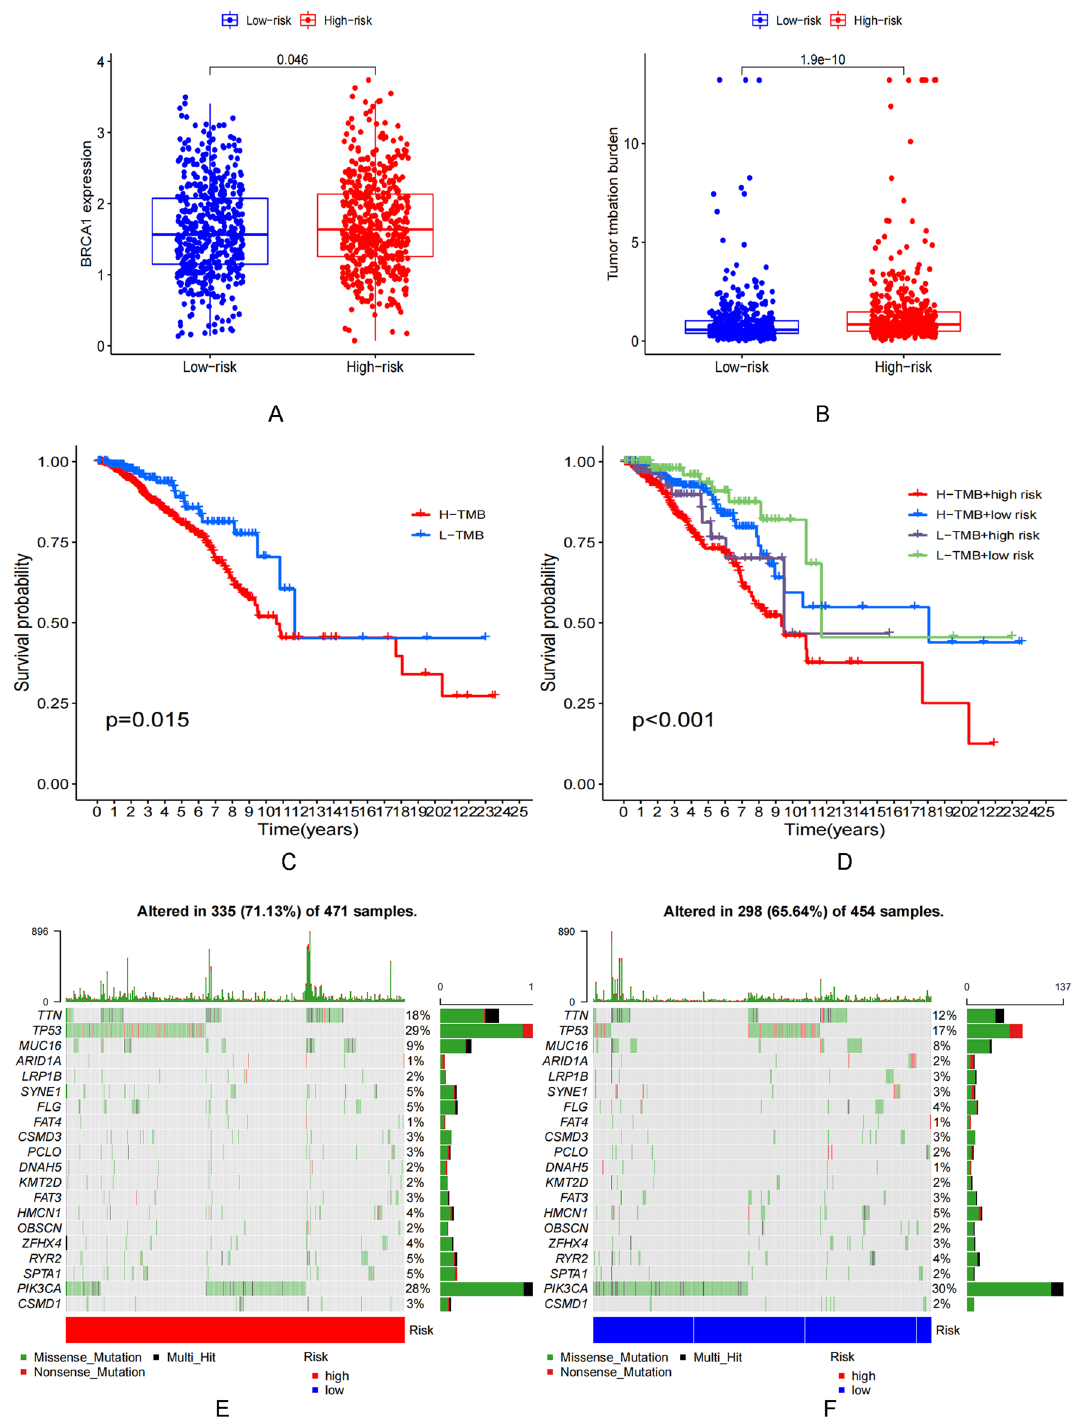
Figure 7. Construction of the ARSP-lncRNAs risk score. ( A ) BRCA1 expression in high and low risk group. ( B ) Correlation of BRCA1 with risk score. ( C ) TMB status in high and low risk group. ( D ) Correlation of TMB with risk score. ( E ) Prognostic analysis of TMB. ( F ) Prognostic analysis of TMB with high and low risk group. ( G , H ) Waterfall plots of somatic mutation characteristics in high and low mortality scores. Each column represents an individual